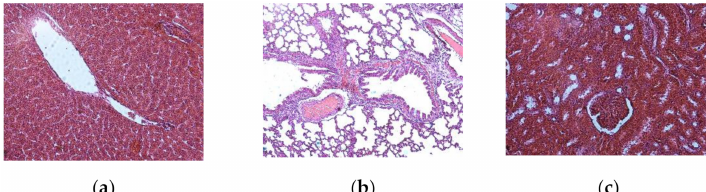
Figure 8. Morphology of the investigated organs for the group treated with 6b (R = 4-F) derivative: ( a ) liver normal morphology, col.HE, x20; ( b ) lung bronchial distension, inflammatory reactions, col.HE, x20; ( c ) kidney normal morphology, col.HE,